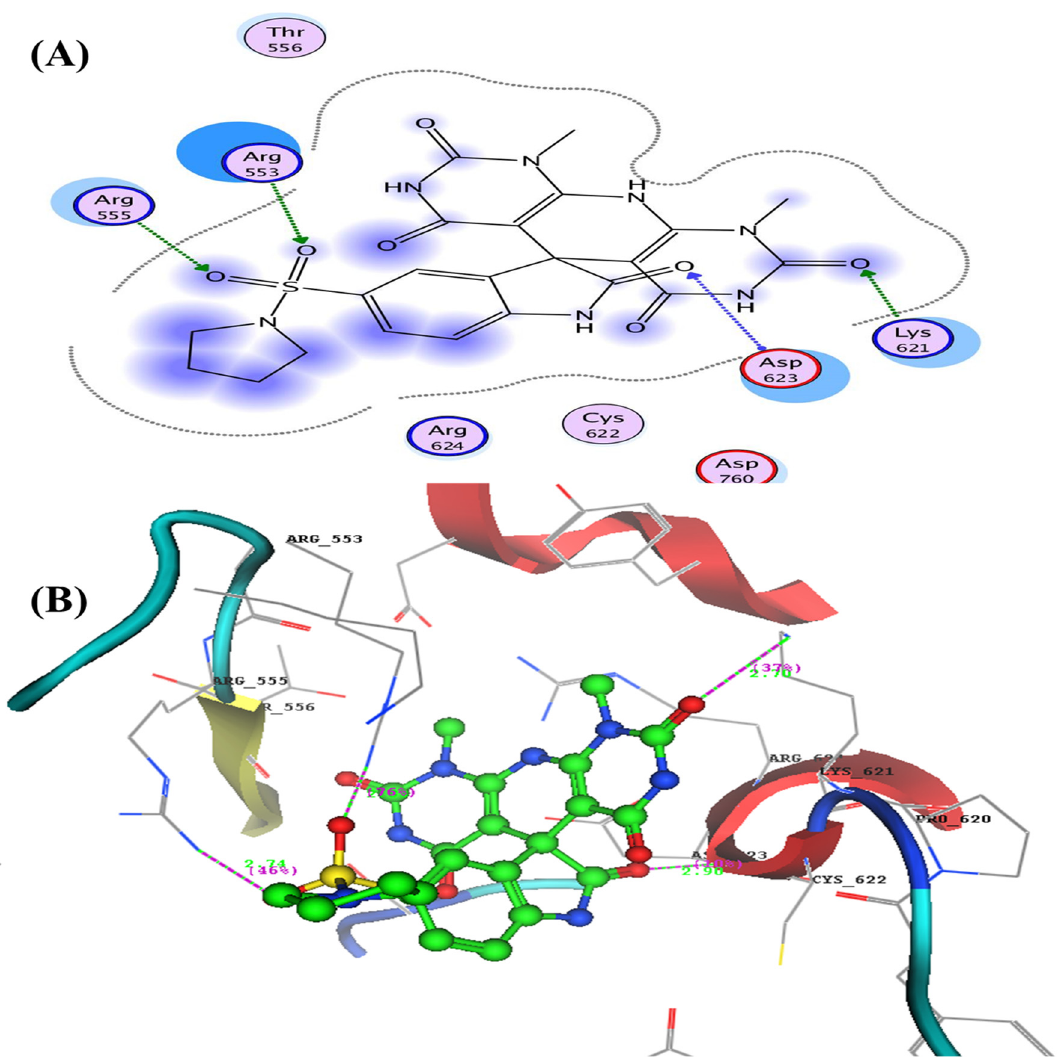
Figure 6. ( A ) 2D and ( B ) 3D structures of compound 3a inside the active site of RNA polymerase (RdRp) (PDB: 6m71).